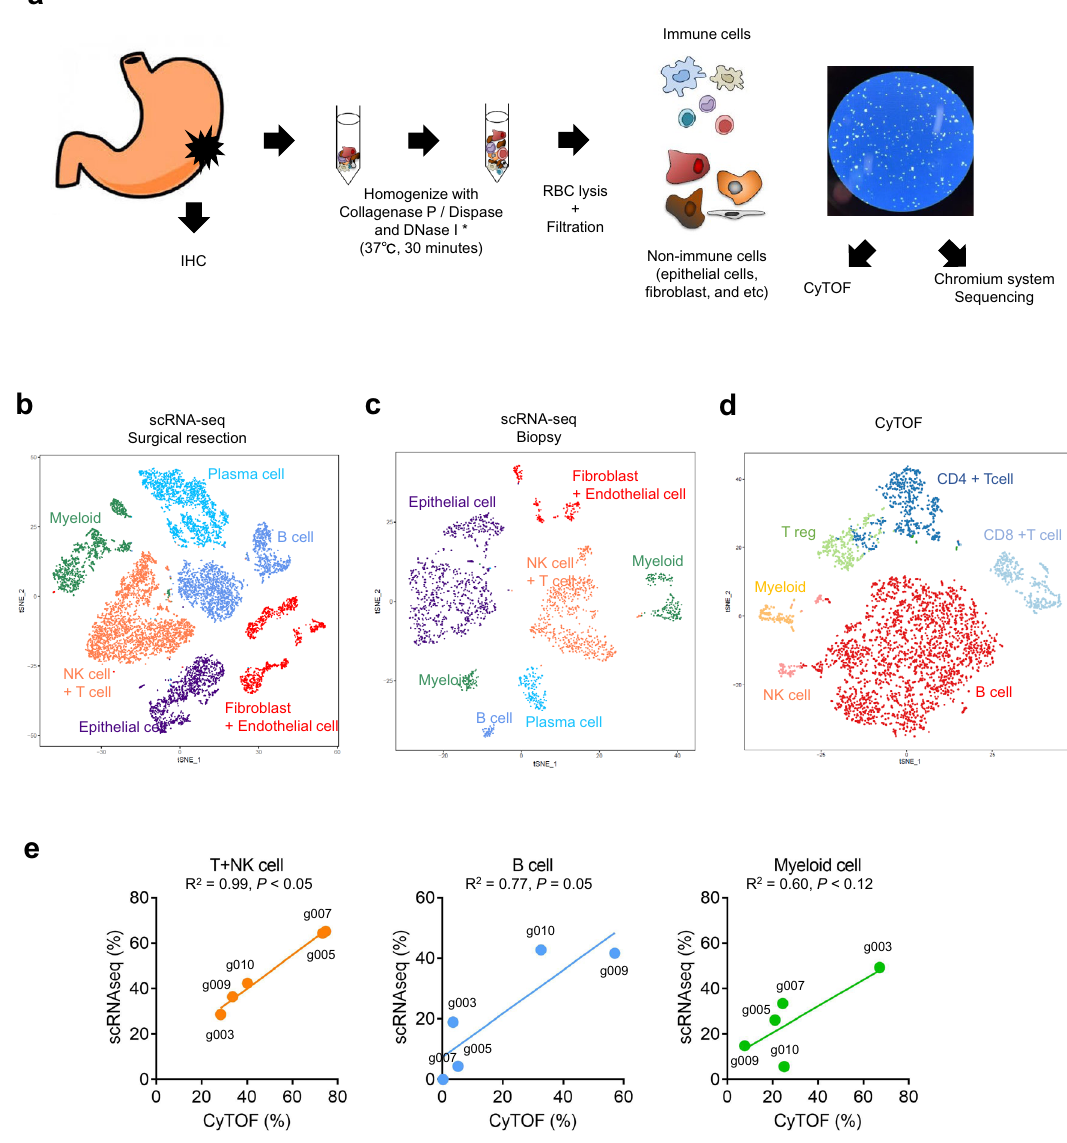
Figure 3. ScRNA-seq using whole tissues could reveal TME. ( a ) The procedure of sample processing. We marked the location of sampling for CyTOF and scRNA-seq. When IHC was performed, we used the marked blocks. Fractions with approximately 5 mm square size from surgically resected samples were used for CyTOF and scRNA-seq. After sampling, tumor tissues were minced, and then isolated using the dissociator. Enzyme treatments were used for scRNA-seq for 30 min at 37 °C (*). The isolated cell suspension was subjected to CyTOF and scRNA-seq at the fresh state. ( b – d ) t-SNE plots based on scRNA-seq of surgical resection ( b ), biopsy sample ( c ), and on CyTOF of surgical resection ( d ). ( e ) Comparison between CyTOF (x-axis) data and scRNA-seq data (y-axis) in each immune-cell population. %T + NK cell, %B cell, and %Myeloid cell in CD45 + immune cells are